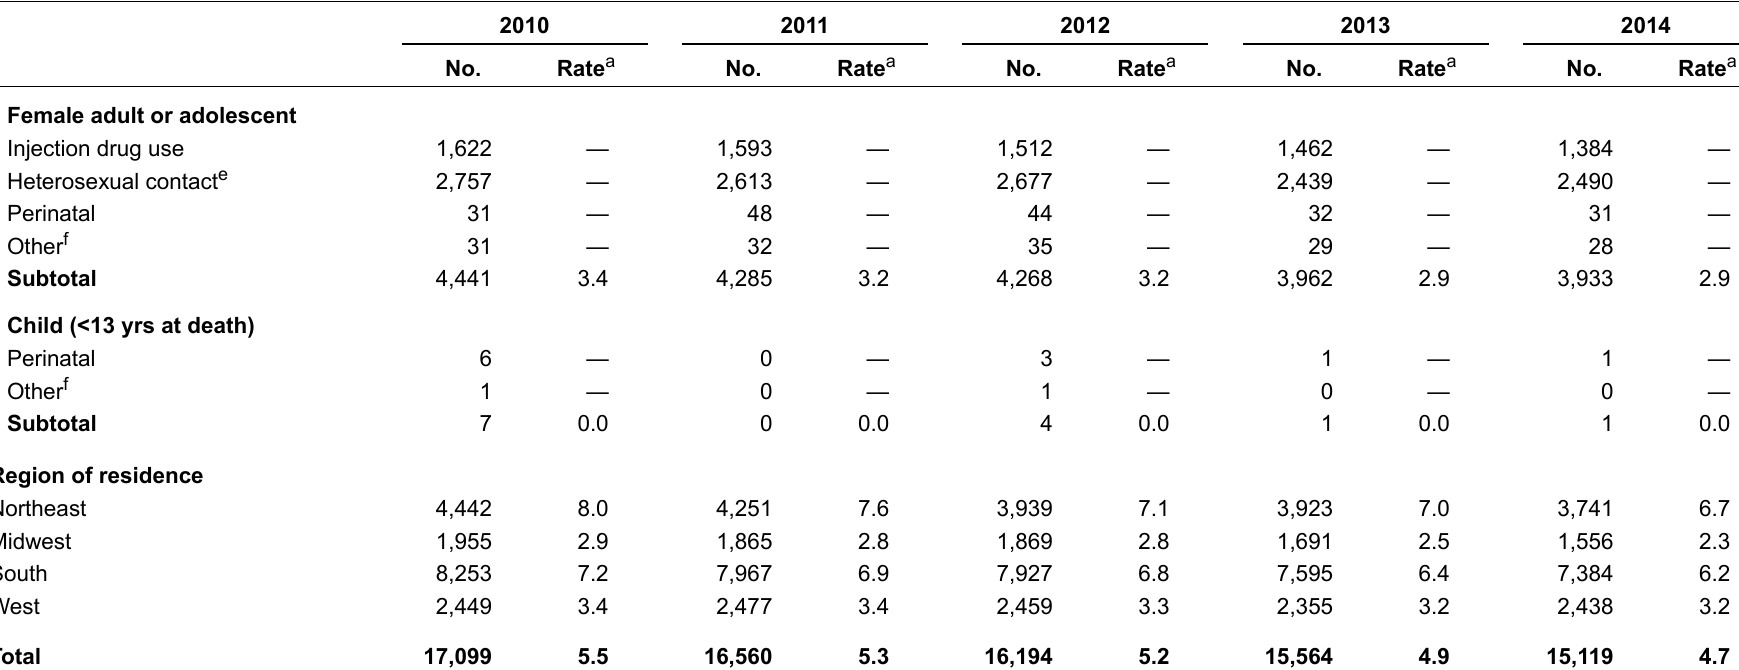
Table 12a. Deaths of persons with diagnosed HIV infection, by year of death and selected characteristics, 2010–2014—United States